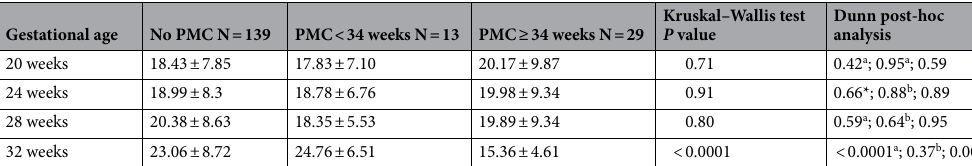
Table 4. Maternal Serum 25(OH)D (ng/mL) according to the term of PMC onset. Continuous variables reported as mean ± standard deviation. Comparison No PMC vs PMC > 34 weeks. PMC